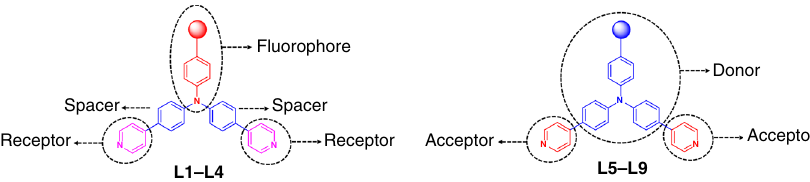
Fig. 6 Schematic illustrations of PET/ICT of ligands L1 –